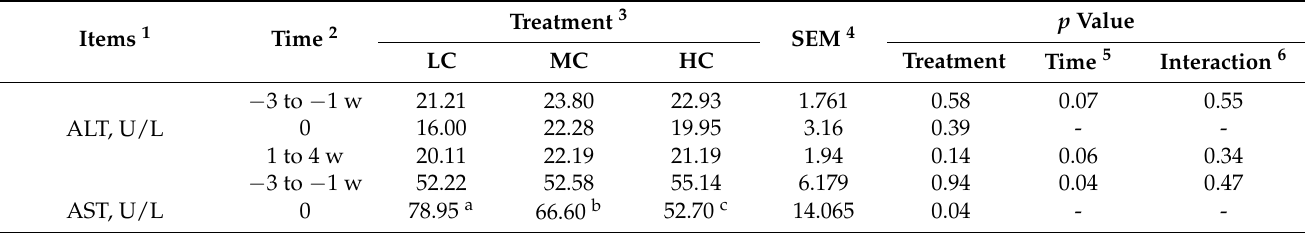
Table 6. Effects of different prenatal concentrate levels on the liver metabolite indicators of prepartum and postpartum dairy